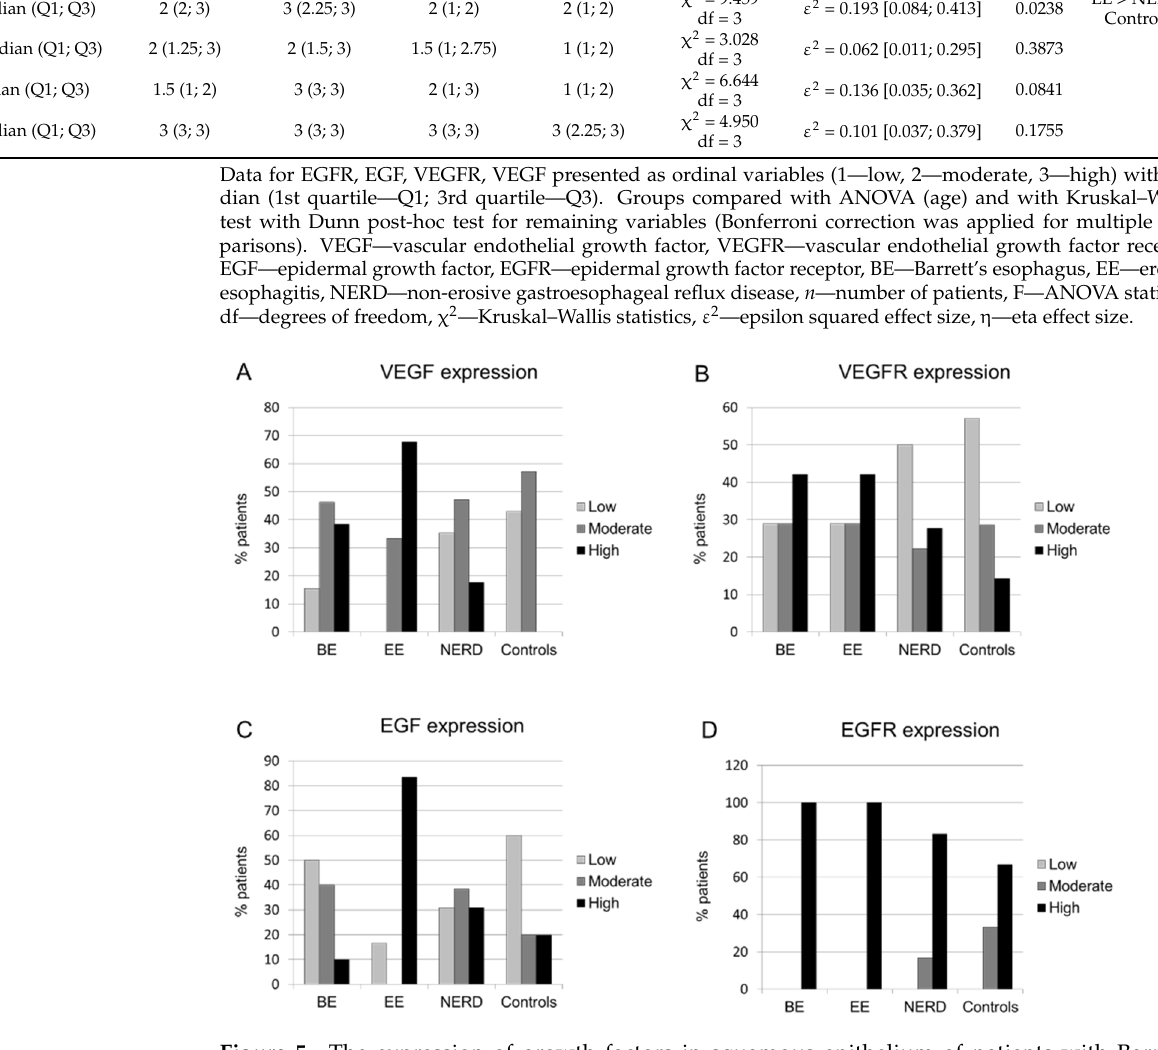
Figure 5. The expression of growth factors in squamous epithelium of patients with Barrett’s esophagus (BE), erosive esophagitis (EE), nonerosive reflux disease (NERD), and healthy controls. ( A )—VEGF, ( B )—VEGFR, ( C )—EGF, ( D )—EGFR. VEGF expression was significantly higher in EE than in NERD and control group. Other differences were not significant.